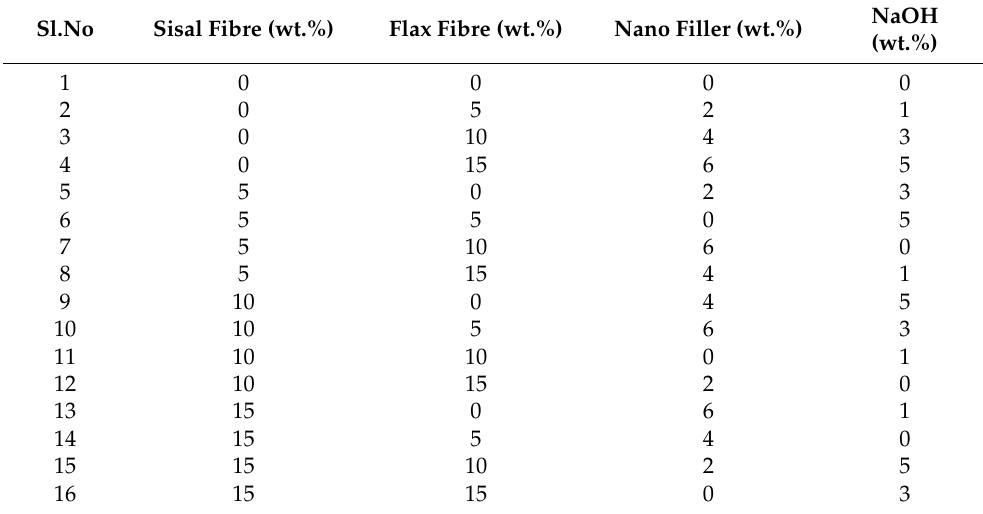
Table 2. L 16 Taguchi Orthogonal